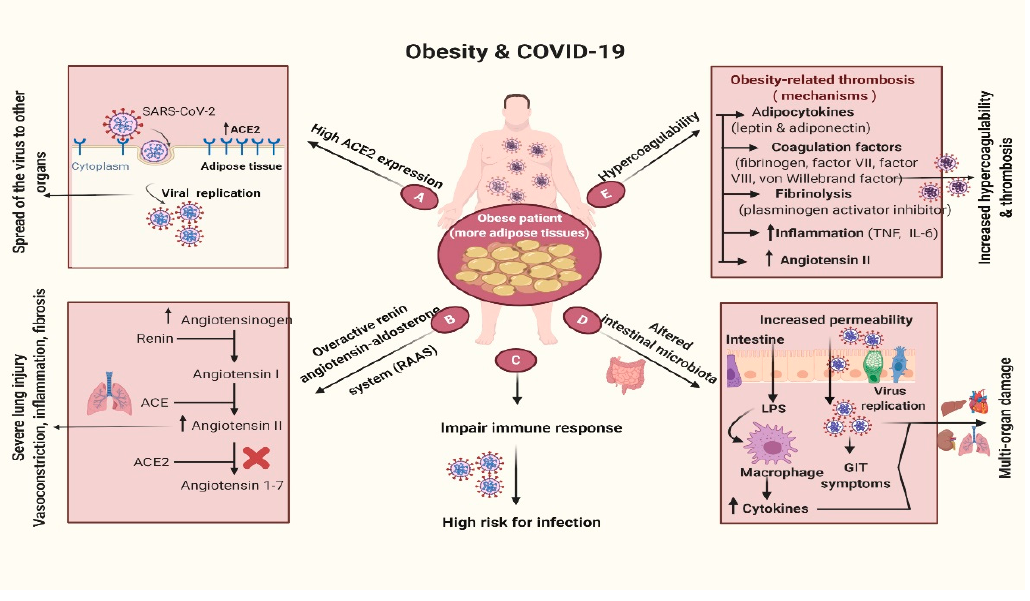
Figure 3. COVID ‐ 19 and obesity. Figure 3. COVID-19 and